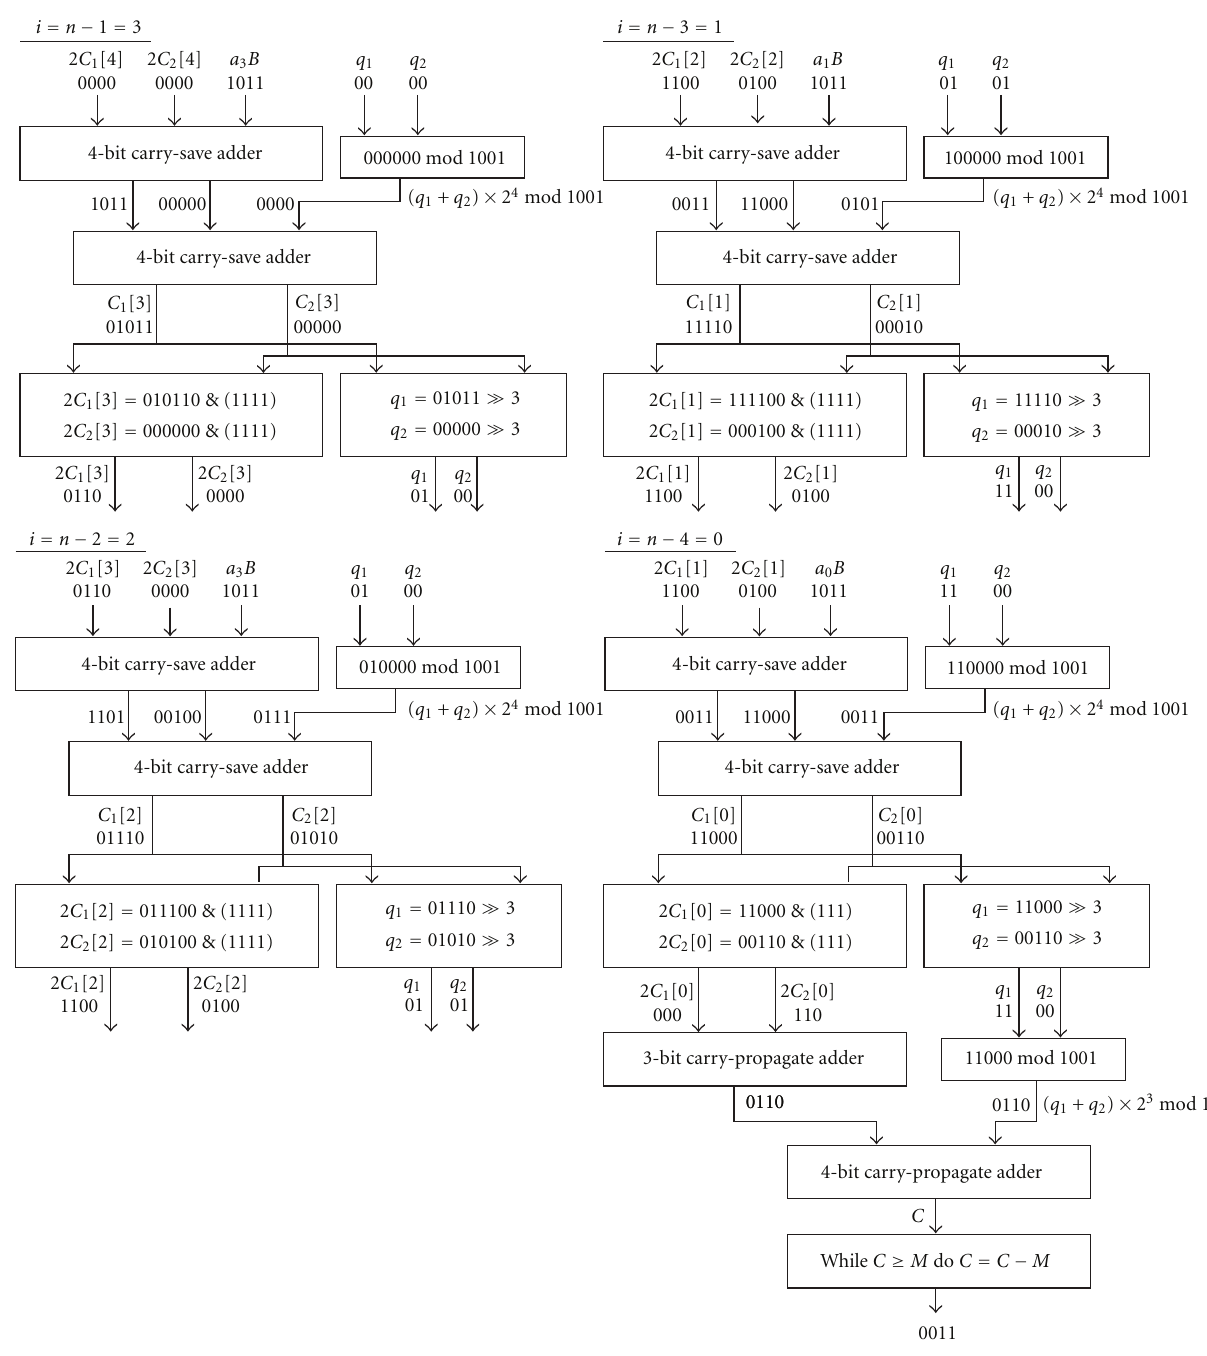
Figure 5: An example for the new algorithm n = 4, A = (1111)